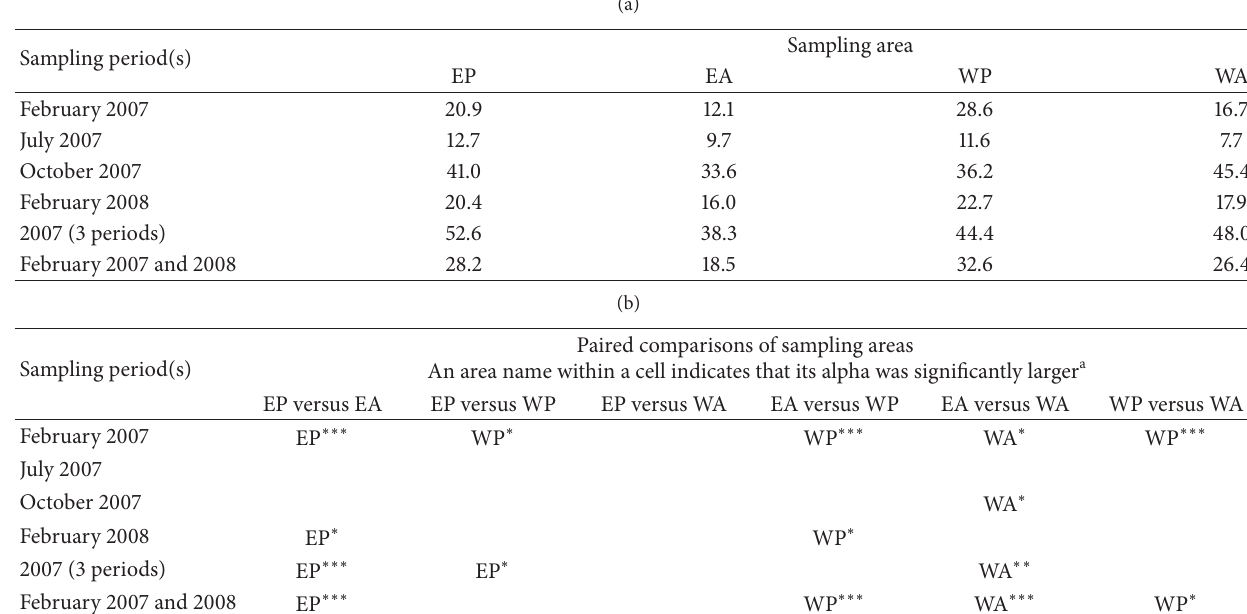
Table 3: (a) Fisher’s alpha indices of diversity for each sampling area in each sampling period or combination of periods. (b) Results of Student’s 𝑡 -tests indicating where significant differences occurred and, if so, which area had the larger